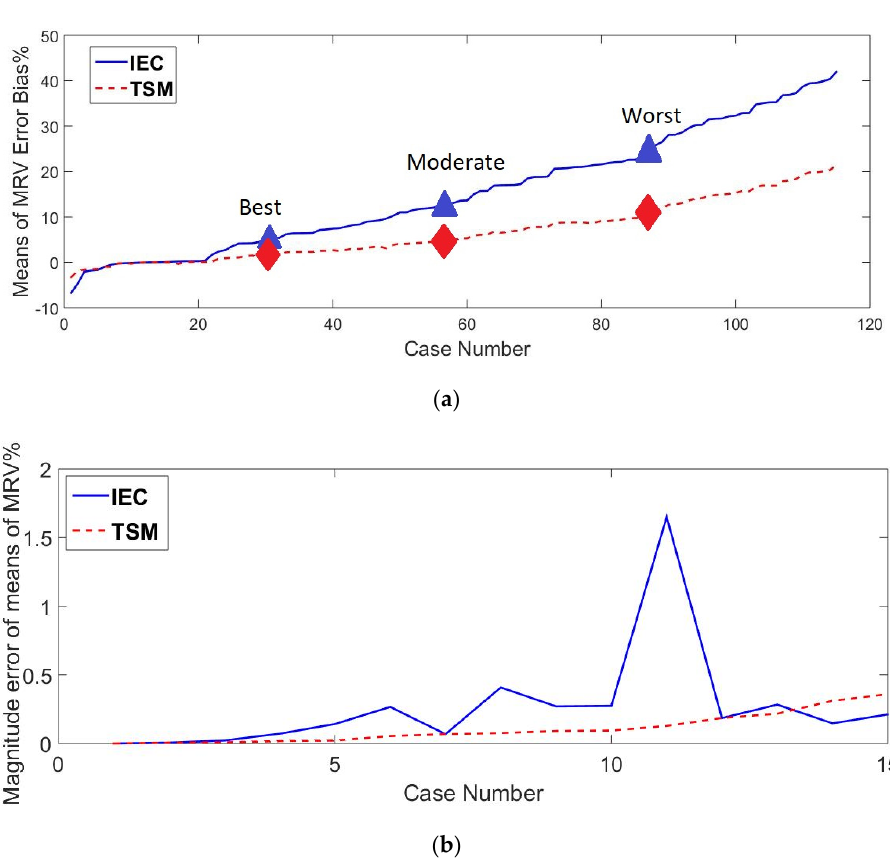
Figure 8. Mean of MRV error due to Doppler noise, turbulence intensity and tilt ( a ) for all the cases with ordered case number; ( b ) For 15 cases when the magnitude of the error bias is low. Here, MRV: Mean Representative Velocity, IEC: International Electrotechnical Commission and TSM: Temporal-Spatial method.